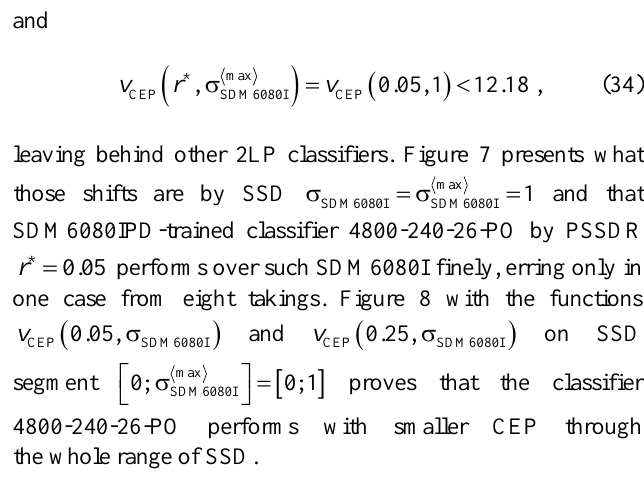
the whole range of SSD.